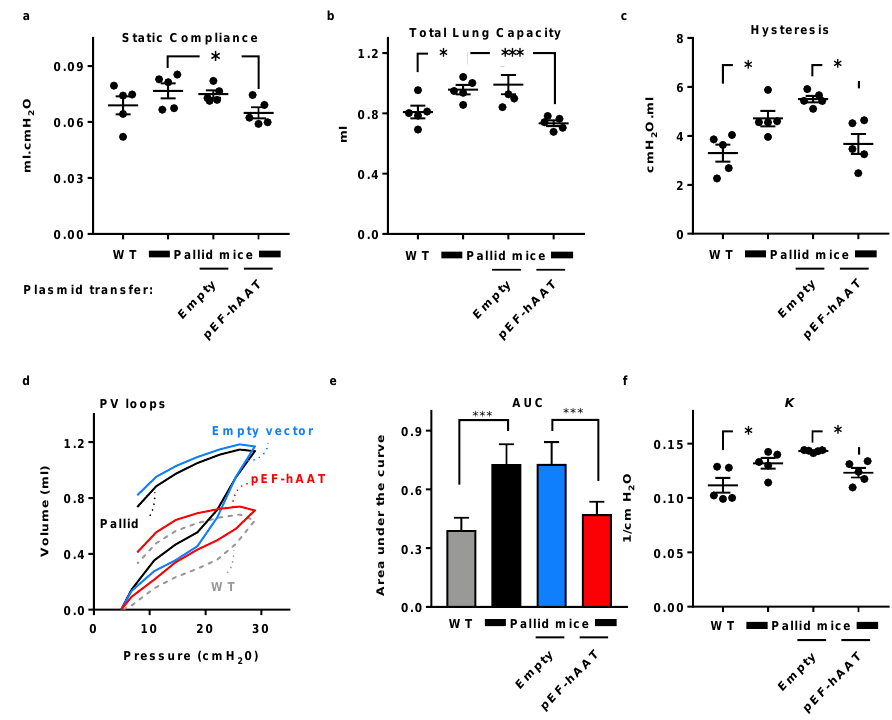
Figure 2. Lung function in pallid mice after intrahepatic electroporation-mediated hAAT gene transfer. Respiratory parameters were performed on a flexiVent system (SCIREQ): static compliance, total lung capacity, and hysteresis were obtained in tracheotomize mice. B6, C57BL / 6 mice; Pa, pallid mice; EV, pallid mice treated with an empty vector; AAT, pallid mice treated with AAT plasmid ( n = 5 per group). Lung function measurements: ( a ) static compliance, ( b ) total lung capacity, and ( c ) hysteresis (area under the (pressure volume) PV loop). Static compliance was calculated from the deflating part of the PV loop between 3–7 cm H 2 O, total lung capacity was measured using a deep inflation manoeuvre, and hysteresis represents the area between the inflating and deflating parts of the PV loop. Each symbol represents the average of three correct manoeuvres per mouse. Values are shown as mean ± SD; * p < 0.05, *** p < 0.001 compared to untreated control group. ( d ) Pressure-volume (PV) loops, ( e ) analysis of the PV-loops, and ( f ) parameter K representing the curvature of the PV loops curves: Two-way ANOVA applying Bonferroni’s multiple comparisons test compared the mean inspiratory volume of four groups (used at each pressure step up to 30 cm H 2 O). Statistical significance * p < 0.05. t-tests were used in B and C. Values are expressed as mean and ± SD * p < 0.05, *** p < 0.001 compared to the untreated control group. Table 1. Parameters for the lung function test (Figure 2): data are presented as mean ± SD. Parameters WT (Wildtype) Pallid Mice Empty Vector hAAT Plasmid Static Compliance (mL / cmH 2 O) 0.068 ± 0.004 0.064 ± 0.002 Total Lung capacity (A) (mL)